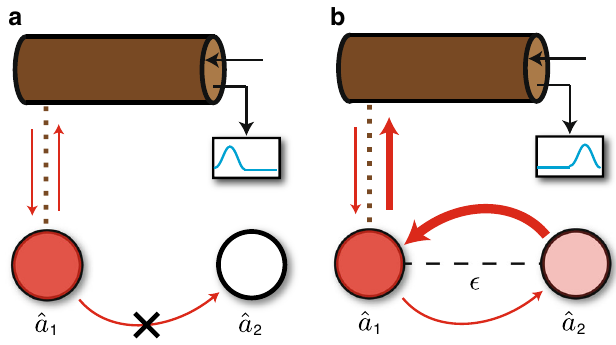
Fig. 4 Schematic showing how signal power is enhanced by nonreciprocity. Arrows and their thicknesses illustrate the direction and magnitude of in fl uences. a In the absence of any perturbation, nonreciprocity prevents mode 2 being excited by the drive incident on mode 1. Drive photons do not experience the large nonreciprocal tunneling J from mode 2 to 1. b A nonzero coupling perturbation ( ϵ ≠ 0) breaks nonreciprocity. As a result, drive photons can tunnel from 1 to 2, and then return experiencing ampli fi cation from the large nonreciprocal tunneling amplitude J . This gives a large